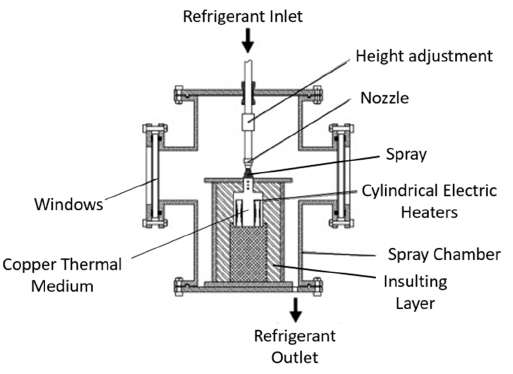
Figure 15. Schematic of closed loop spray cooling system [87].